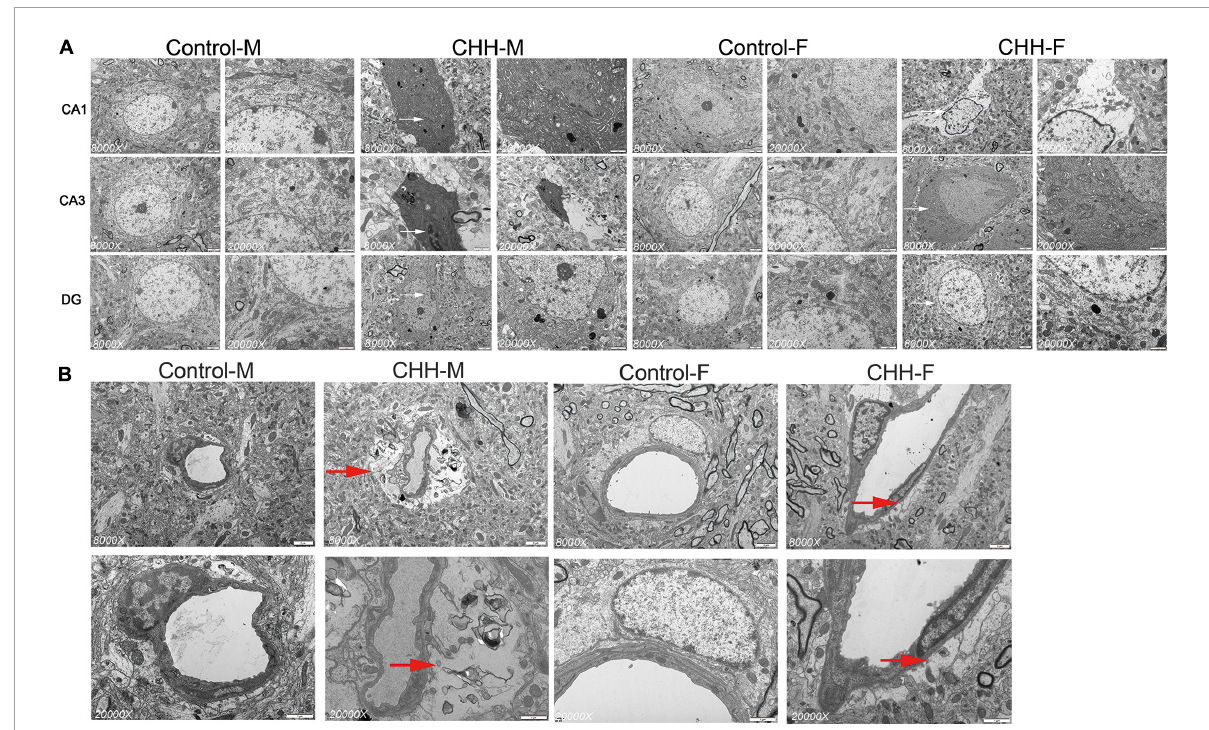
FIGURE11 Ultrastructure of hippocampal neurons and blood vessels in female and male CHH groups and control groups (A) shows the ultrastructure of neurons in hippocampal CA1, CA3, and DG regions; Early apoptosis or apoptotic signs (white arrow) and swelling of neuronal mitochondria were observed in CHH group; (B) It shows the ultrastructure of the vessels in the hippocampal CA3 area. The red arrow in the micrograph shows the widening of the space around the blood vessel (red arrow). (A) Scale bar = 2 µ m. (B) Scale bar = 1 µ